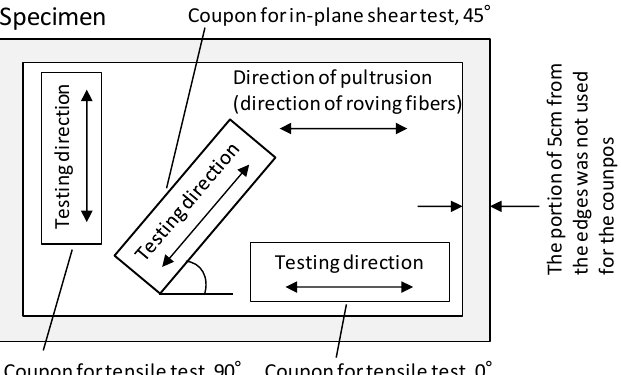
Coupon for tensiletest, 0 ° Coupon for tensiletest, 90 ° Figure 4. Test coupons cut out from the exposed specimens.